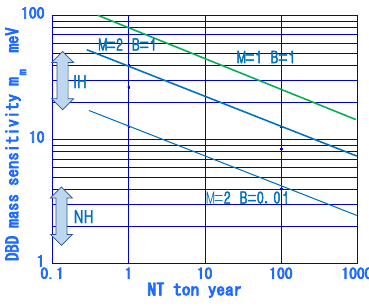
Figure 4. Double beta decay (DBD) neutrino-mass sensitivities m m in the cases of the NMEs M 0 ν = 1, 2 and B = 1/t y and 0.01/t y as a function of the exposure NT . Here k = 40 meV, η = 0.9 and (cid:101) = 0.6 are assumed. The arrows with IH and NH are the mass regions for the IH and NH